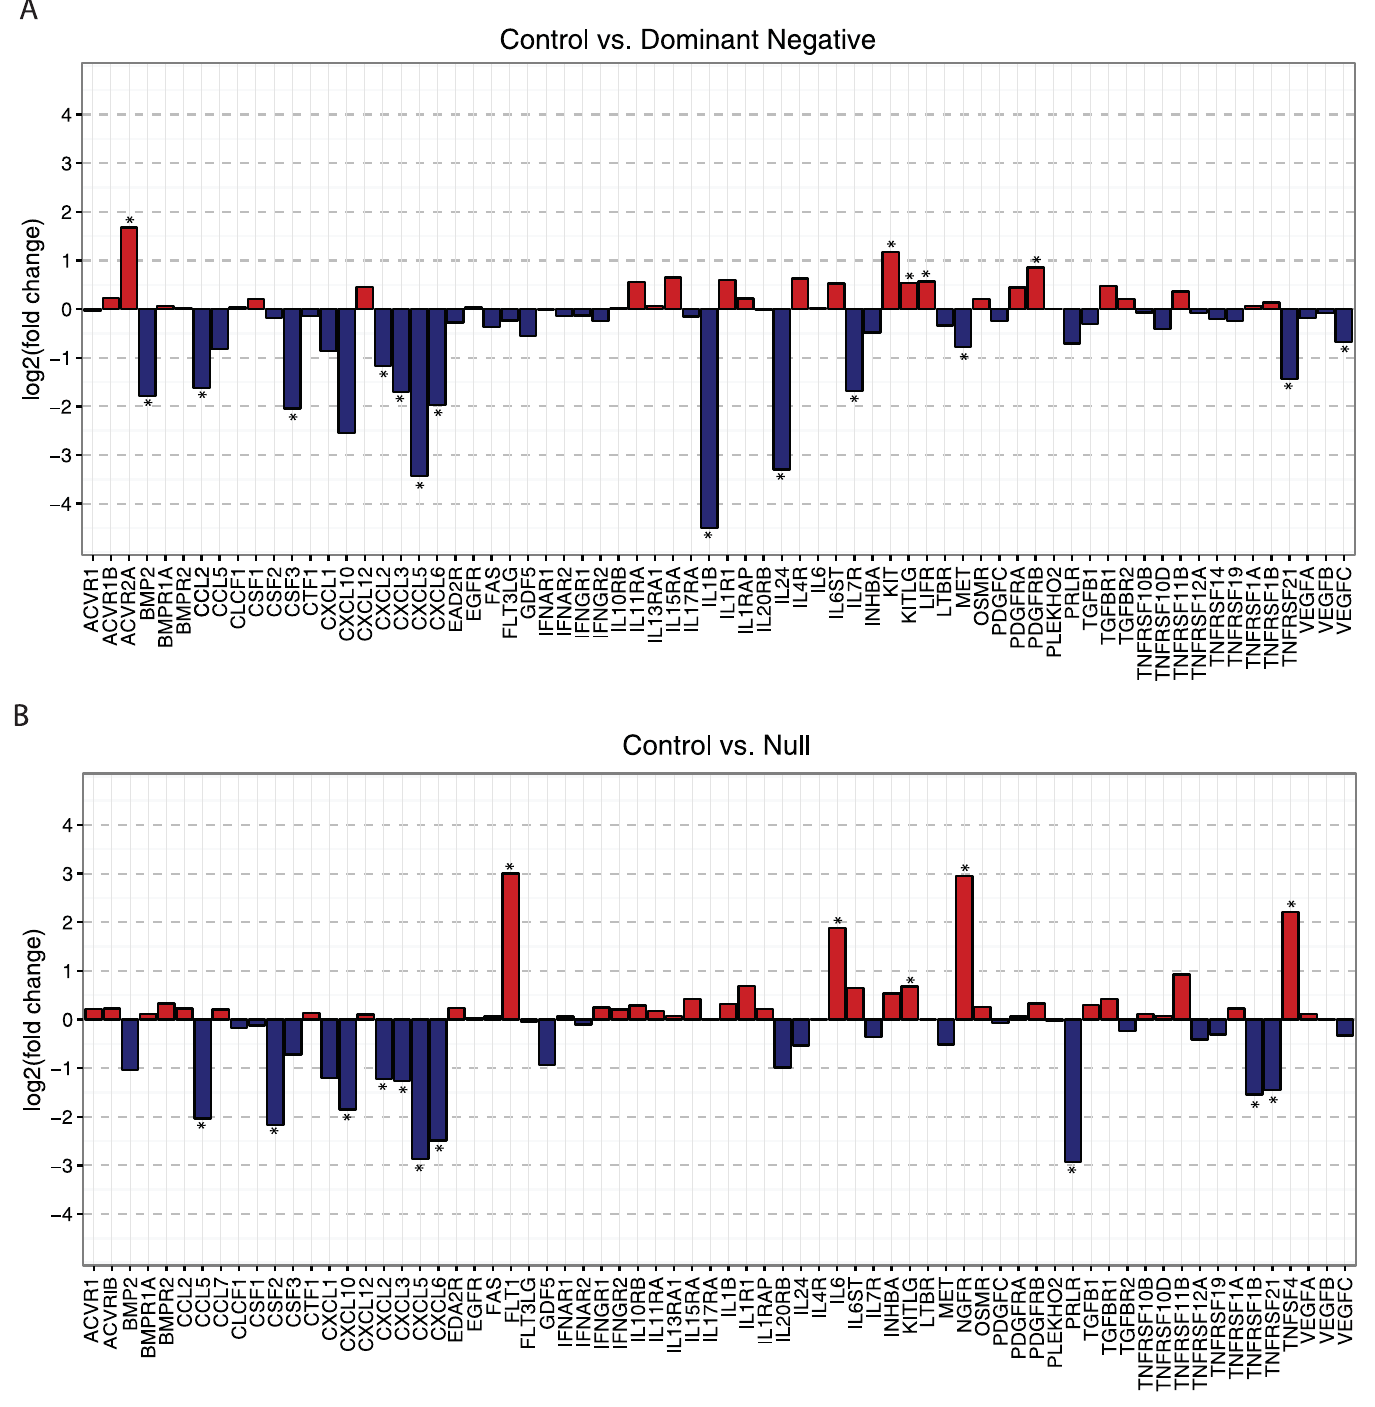
Fig 3. Differential expression of genes in the cytokine-cytokine receptor interaction pathway. Differential expressionof genesin the cytokine-cytokine receptor interaction pathway (hsa04060) for control vs. dominant negativemutation (upper panel) and control vs. null mutation (lower panel). Log 2 fold changeis plotted for each gene in the pathway. Genes with significantdifferential expression(FDR-adjustedp-valuewas < 0.05) are marked with an * .